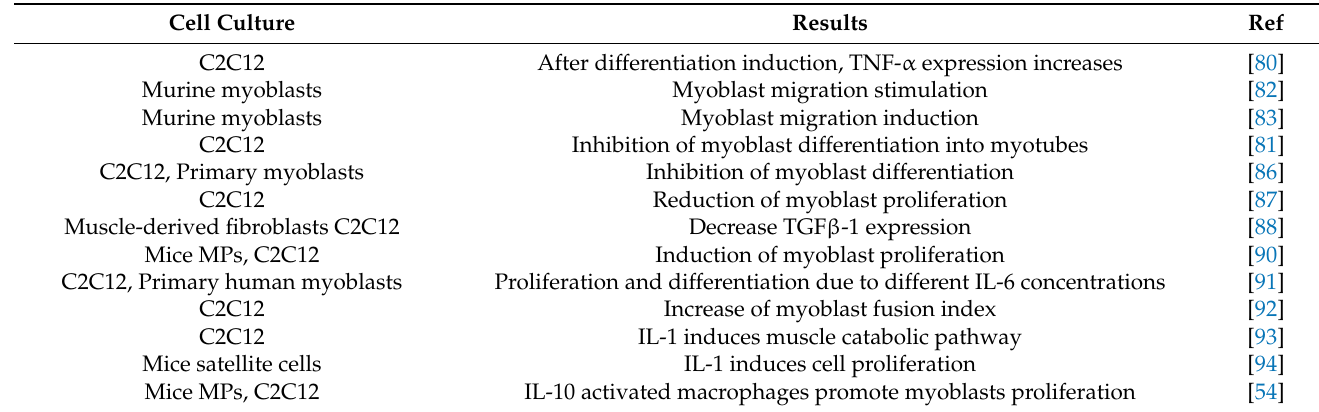
Table 4. Cytokines and skeletal muscle regeneration. In vitro